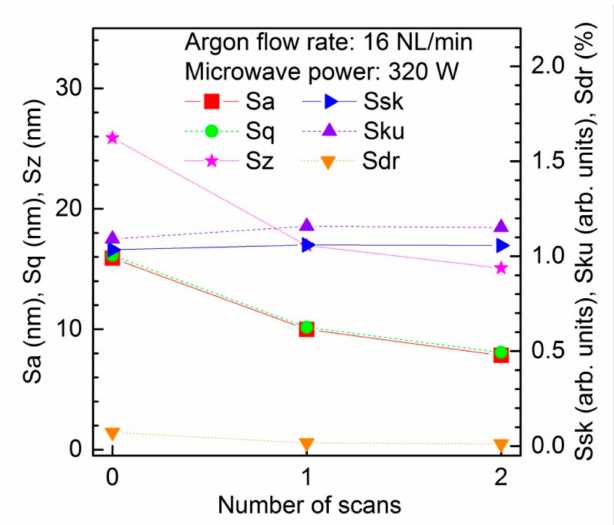
Figure 6. Dependence of the roughness parameters (Sa, Sq, Sz, Ssk, Sku, Sdr) of the polycarbonate sample on the number of plasma scans. Argon flow rate 16 NL / min. Microwave power 320